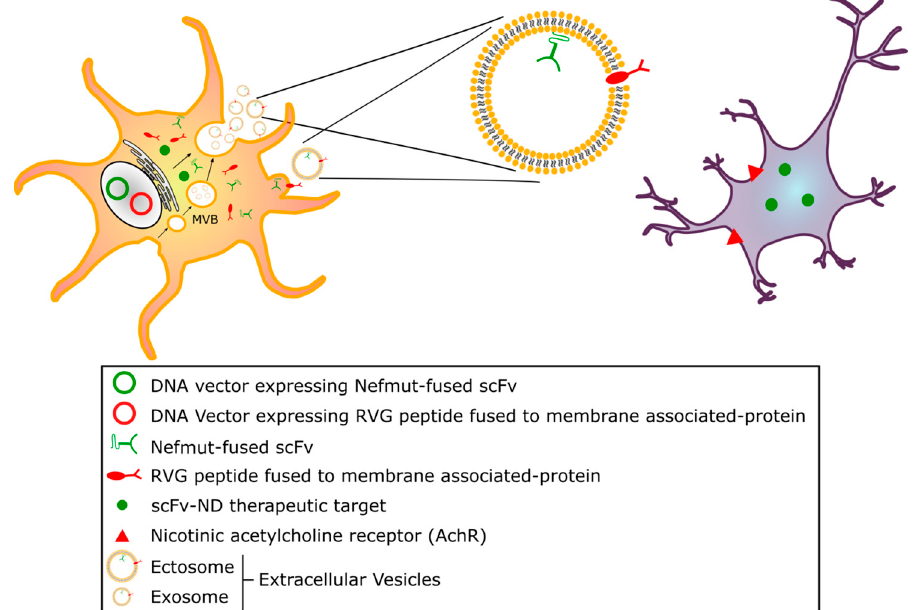
Figure 3. Exosome model for delivering intrabodies against NDs. The model we propose relies on Nef mut -based endogenously engineered extracellular vesicles (EVs), produced in vivo by cells expressing vectors encoding a Nef mut -scFv fusion intrabody specific for the ND molecular target of